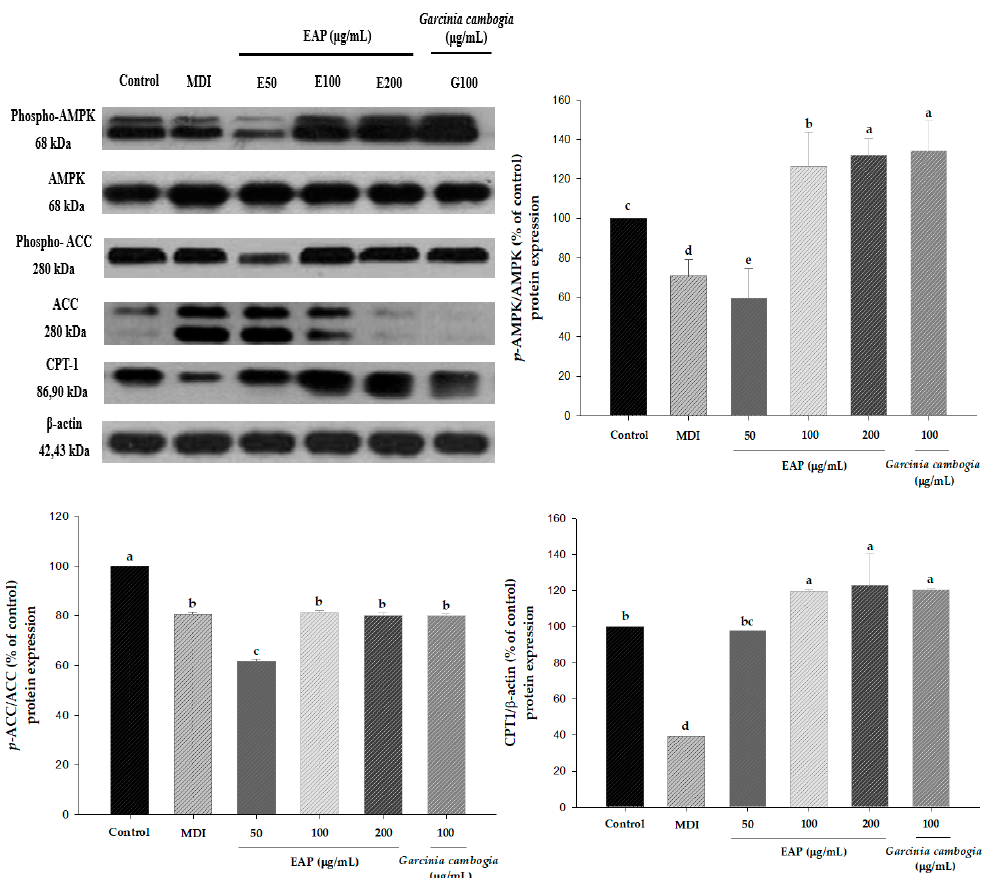
Figure 7. Effects of EAP on the activation of AMPK signaling in 3T3-L1 adipocytes. EAP: Erigeron annuus (L.) Pers. water extract. Cells were treated with EAP at 200 μ g/mL during MDI-induced adipocytes. p -AMPK, AMPK, p -ACC, ACC, and CPT1 were determined by Western blot analysis. Band densities of p -AMPK and p -ACC were quantified and normalized with those of AMPK and ACC expression levels, respectively. Values are presented as mean ± standard deviation. Differences between means were considered statistically significant at P < 0.05.